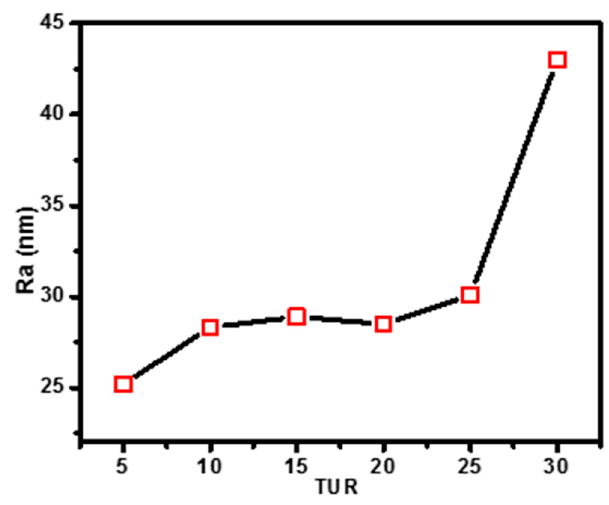
Figure 6. The surface roughness R a of different PE/EMAA films as characterized by